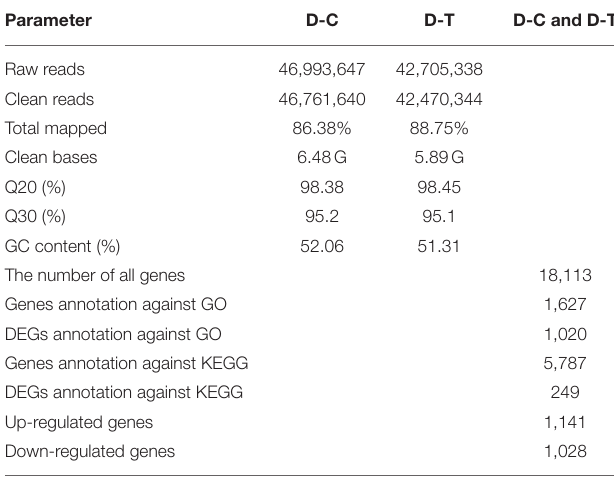
TABLE 2 | RNA-seq data in control (D-C) and treatment (D-T) of P. digitatum .